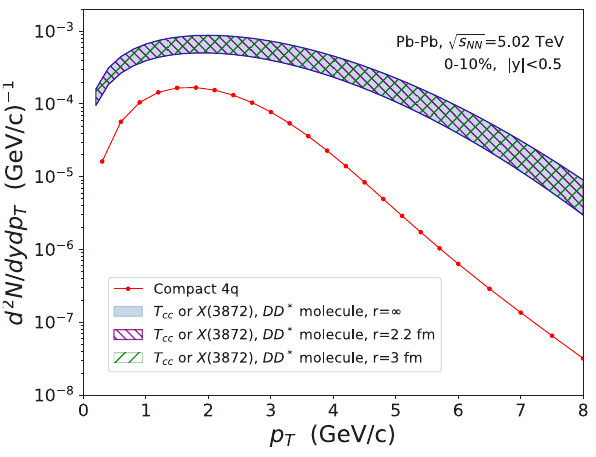
Figure 1. The transverse momentum distribution of X (3872) and T cc (0–10% event). The bands for molecular configurations are due to the uncertainties in the input